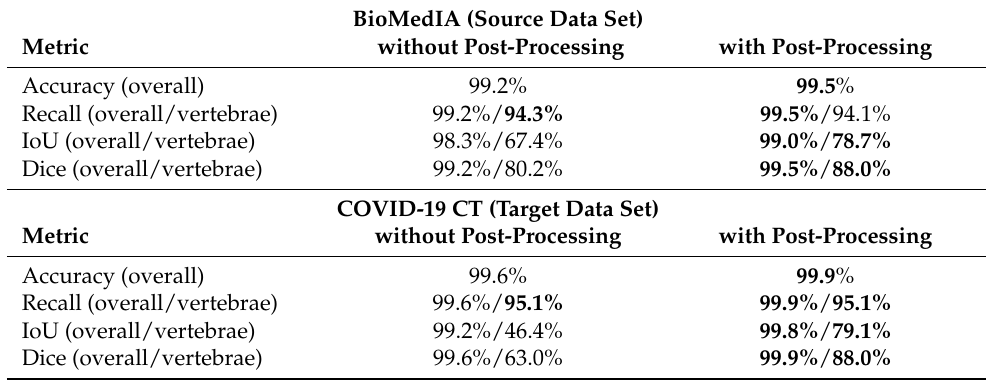
Figure 4. Four randomly selected samples from the target data set (COVID-19 CT) with overlayed predictions for the spine detection with ( bottom row ) and without ( top row ) post-processing. To provide a better grasp of the post-processing’s effect, we visualize all predictions within the 3D mask along the sagittal plane ( left ) and along the coronal plane ( right ). Table 1. Performance evaluation of the Detection module with the highest score for each metric and data set in bold. For each metric, the overall performance for the whole 3D scan and for the vertebrae with ignored background is reported. The positive effect of our proposed the post-processing is visible on the source and the target data